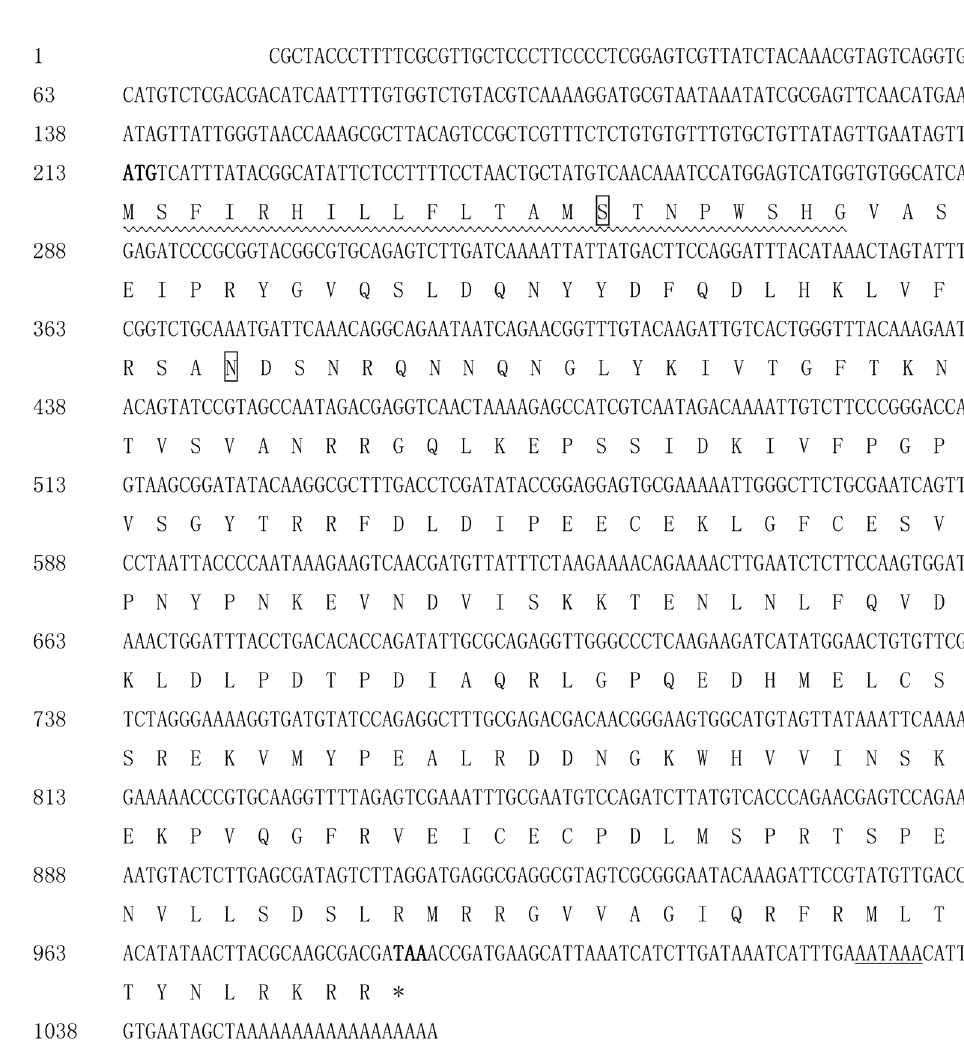
Fig 1. cDNA sequence and deduced amino acid sequence of the ApSPZ gene. Nucleotides are numbered on the left of each line. The deduced amino acid sequence is shown below the nucleotide sequence. The ATG initiation codon is in bold, and the TAA termination codon is in bold and marked with an asterisk. The potential polyadenylation AATAAA sequence near the end of the 3 0 untranslated region is underlined. The predicted signal peptide is wave underlined. This cDNA sequence has been deposited in GenBank under accession number KU323402.